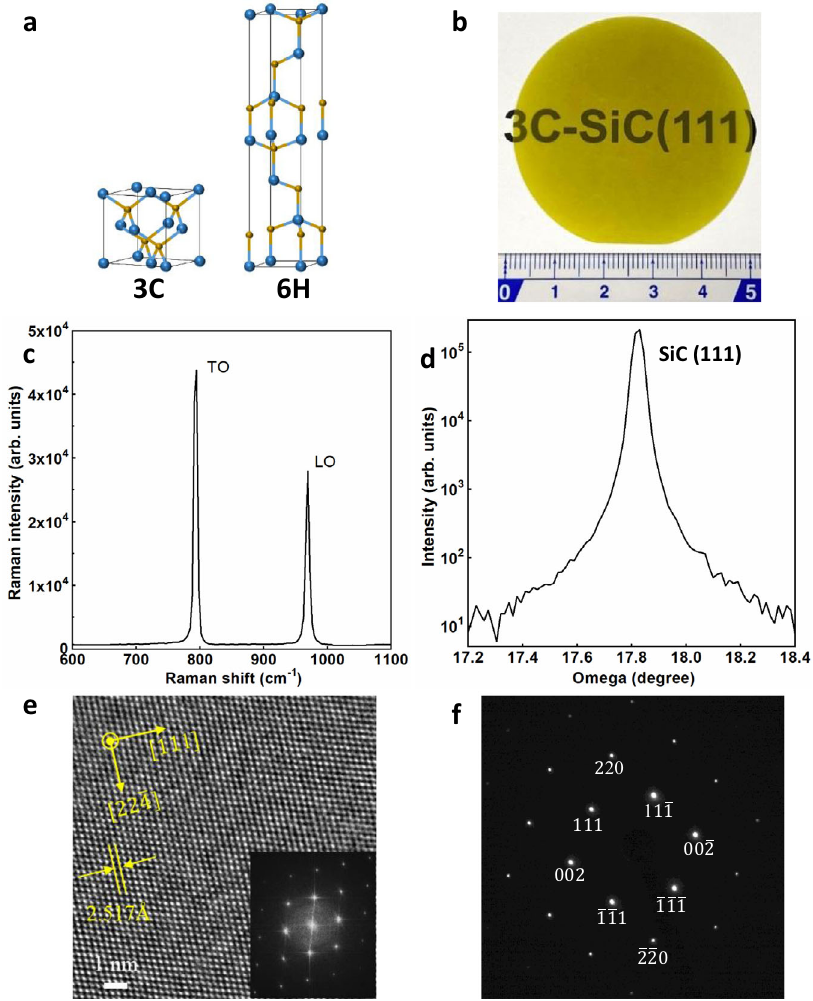
Fig. 1 | Structure of wafer-scale free-standing 3C-SiC bulk crystals. a Atomic structures of 3C-SiC and 6H-SiC. b Picture of a 3C-SiC 2-inch wafer. The unit of the ruleriscm. c Ramanspectrumof3C-SiCcrystal. d X-raydiffraction(XRD)of3C-SiC.